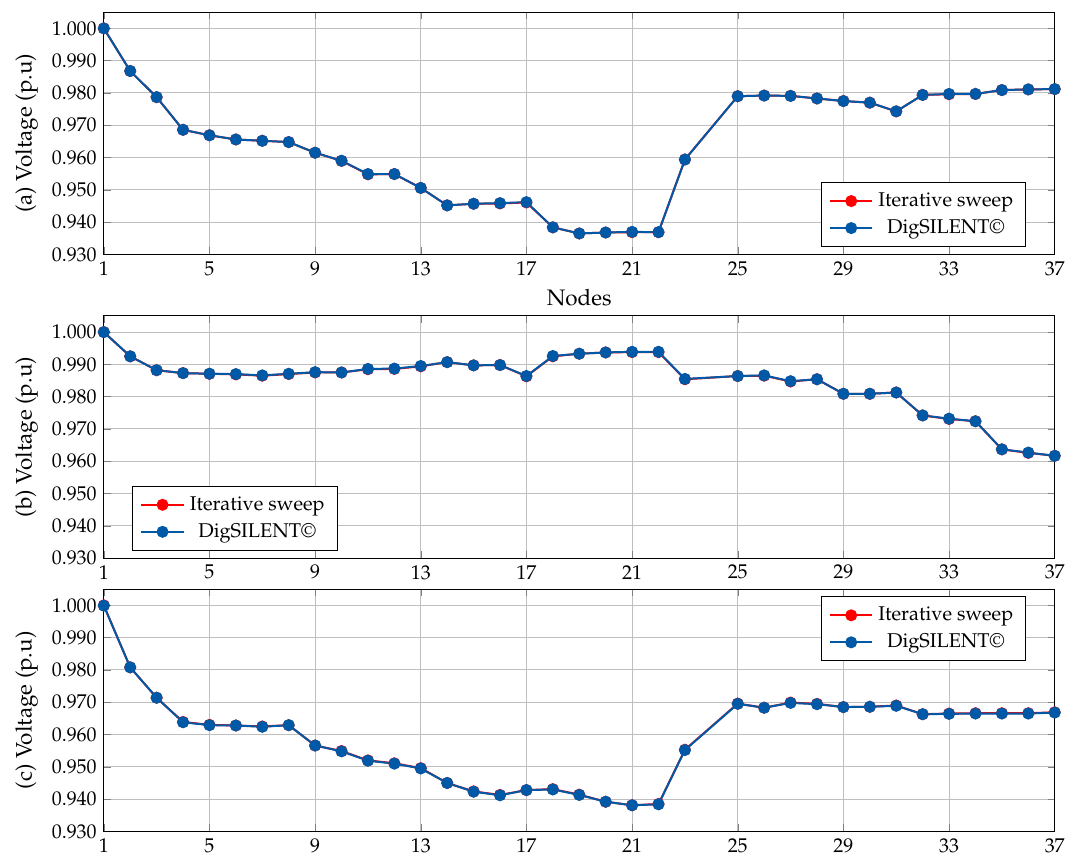
Figure 11. Voltage profiles in the 37 nodes test system: ( a ) phase A, ( b ) phase B, and ( c ) phase